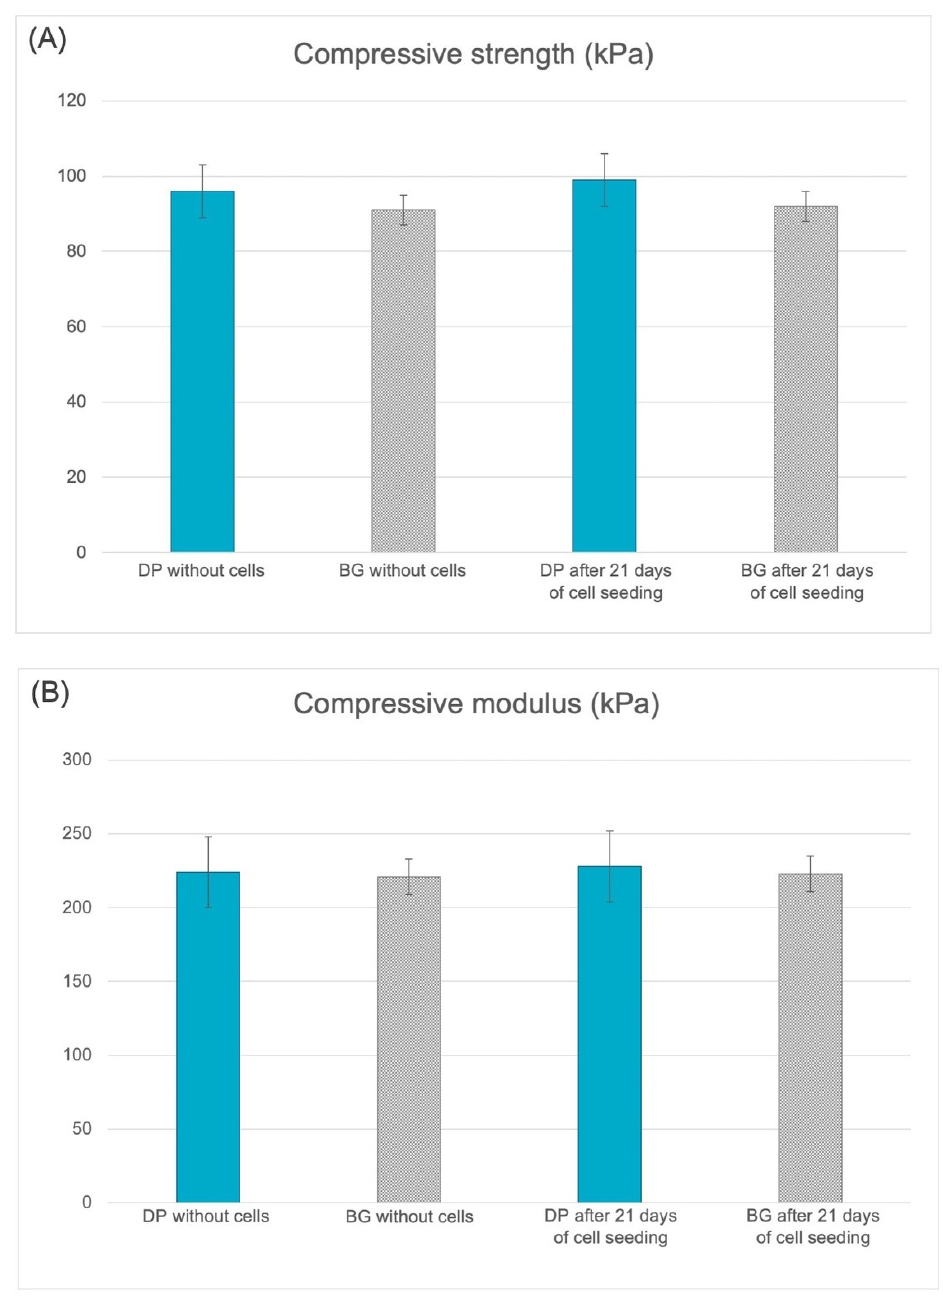
Figure 8. Compressive strength ( A ) and compressive modulus ( B ) of DP and BG without cells and after 21 days of cell seeding.